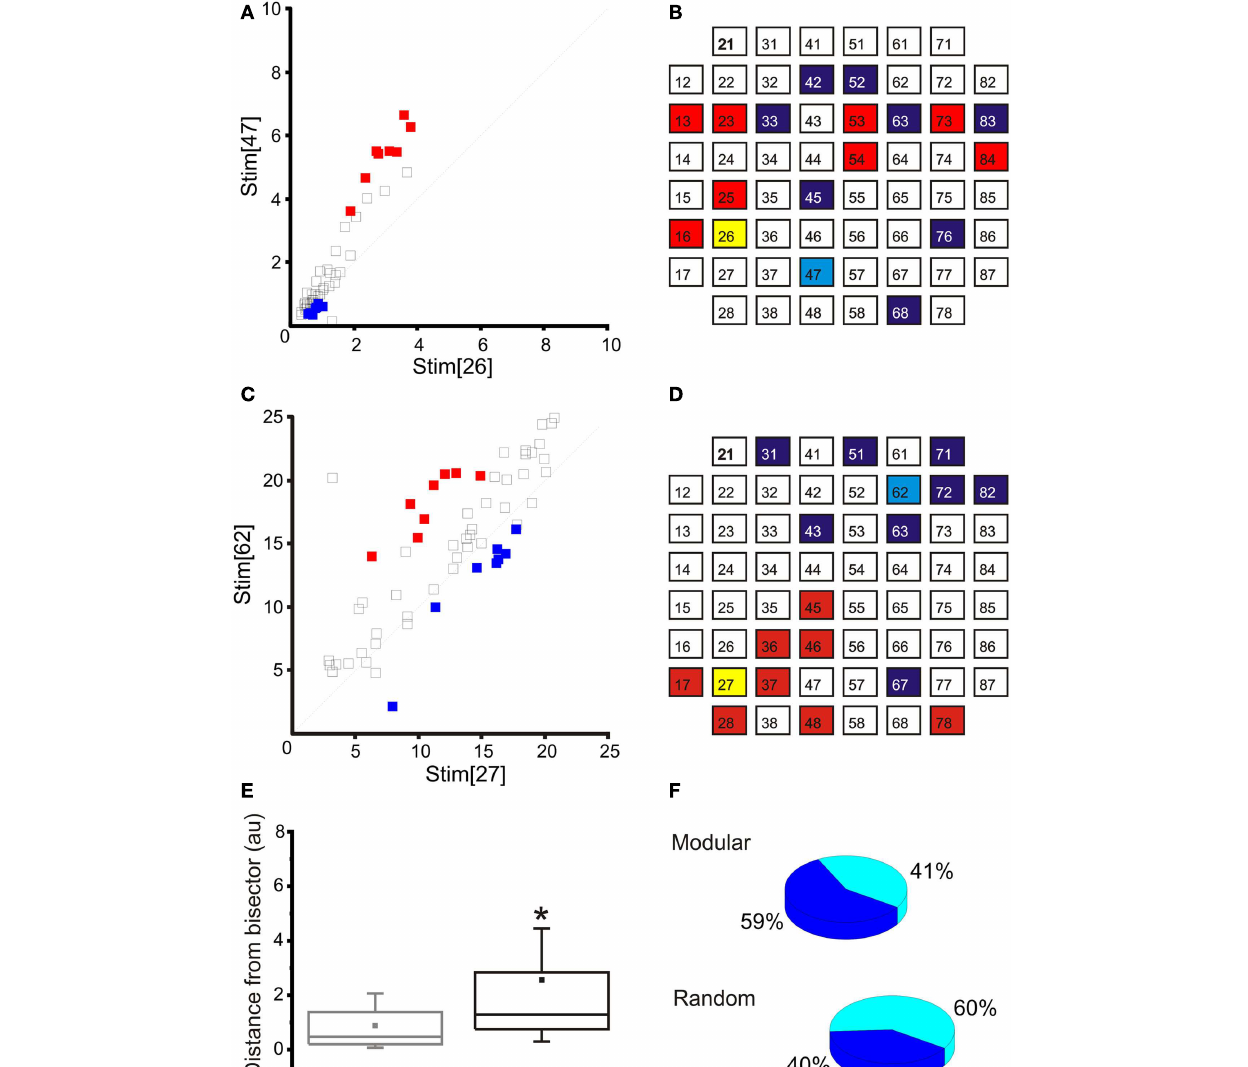
FIGURE 6 | Input-output selection. (A) Map obtained in a representative “random” culture for the selection of the output sites, given two inputs sites (e.g., 26 and 47): red, left recording area; blue, right recording area. (B) Schematic representation of the input (yellow and light blue) and respective recording (red and blue) areas for the same experiment reported in A (“random” culture): note that the selected electrodes are quite spread over the entire recording area. (C) Map obtained in a representative “confined” culture for the selection of the output sites, given two inputs sites (e.g., 27 and 62): red, left recording area; blue, right recording area. (D) Schematic representation of the input (yellow and light blue) and respective recording (red and blue) areas for the same experiment reported in (B) (“confined” culture): note that the selected